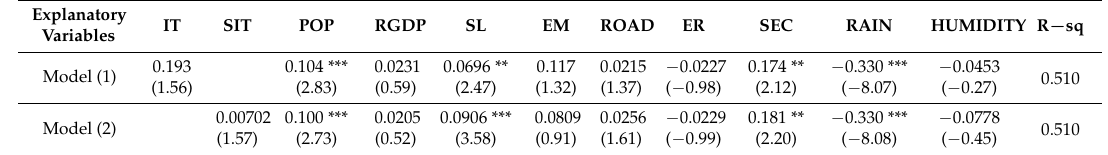
Table 4. OLS analysis estimation results.